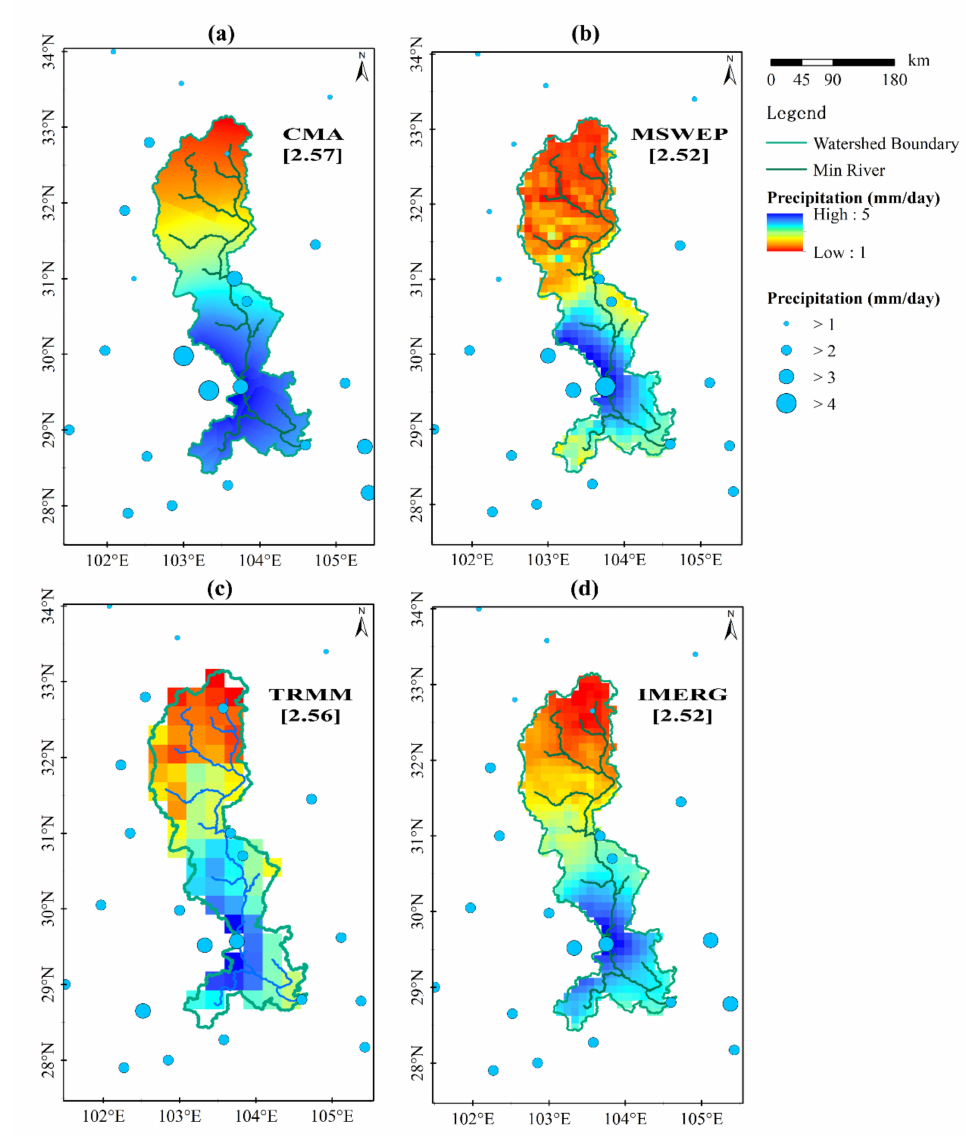
Figure 8. Spatial distributions of 16-year (2000–2016) mean precipitation (mm/day) across the Min Jiang watershed from the ( a ) CMA, ( b ) MSWEP, ( c ) TRMM, and ( d ) IMERG products. The watershed average value of each precipitation product is included in the brackets in each figure. As calculated at the watershed average scale, the various daily statistical indices of gridded precipitation are presented in Table 2. Most of the statistical indices were well- captured by MSWEP, which showed similar skewness, kurtosis, SD , and CV . TRMM was worse at representing the precipitation pattern, with a higher standard deviation (4.17) and coefficient of variation